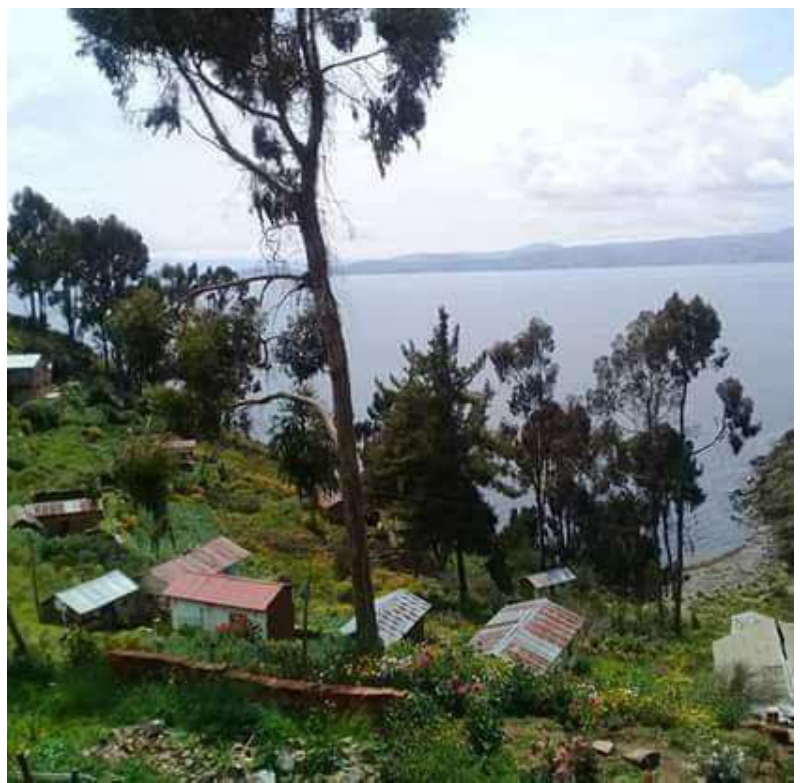
Figure 6: Ayllu Chiquipata . Source : Tania